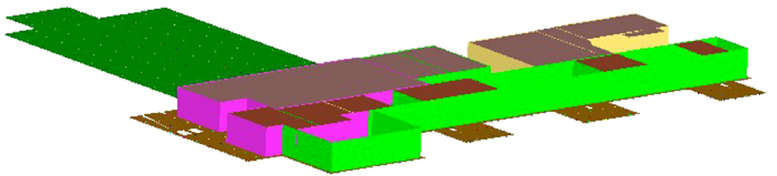
Figure 20. Model of the platform subjected to excitations similar to the 4 March 1977 earthquake.